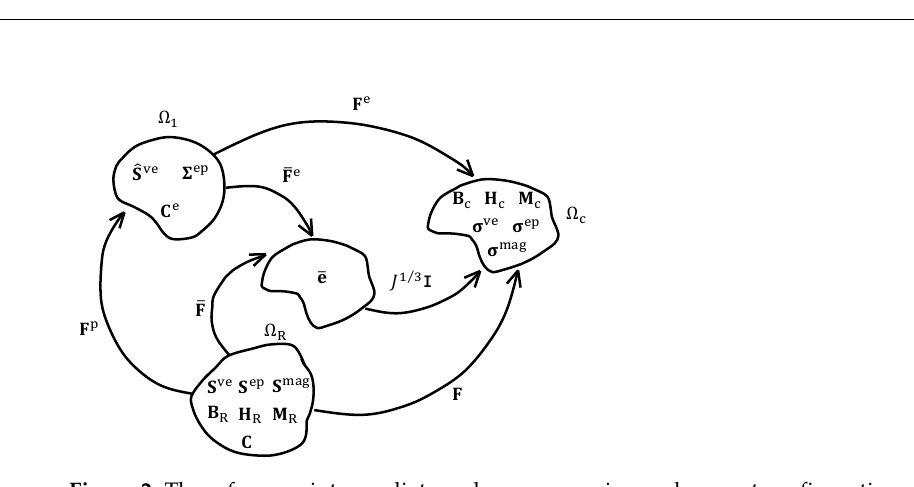
𝐂𝐂 Figure 2. The reference, intermediate, volume preserving and current configurations and the corre- sponding